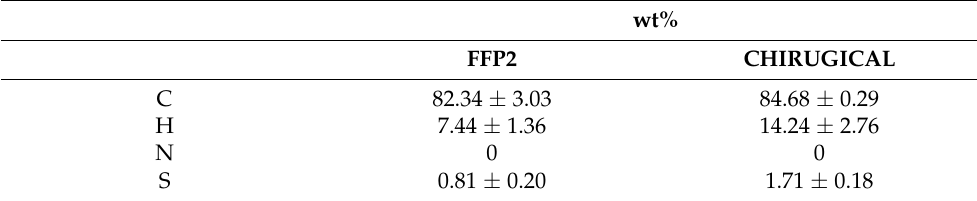
Table 4. Ultimate analysis of FFP2 and chirurgical masks on a dry